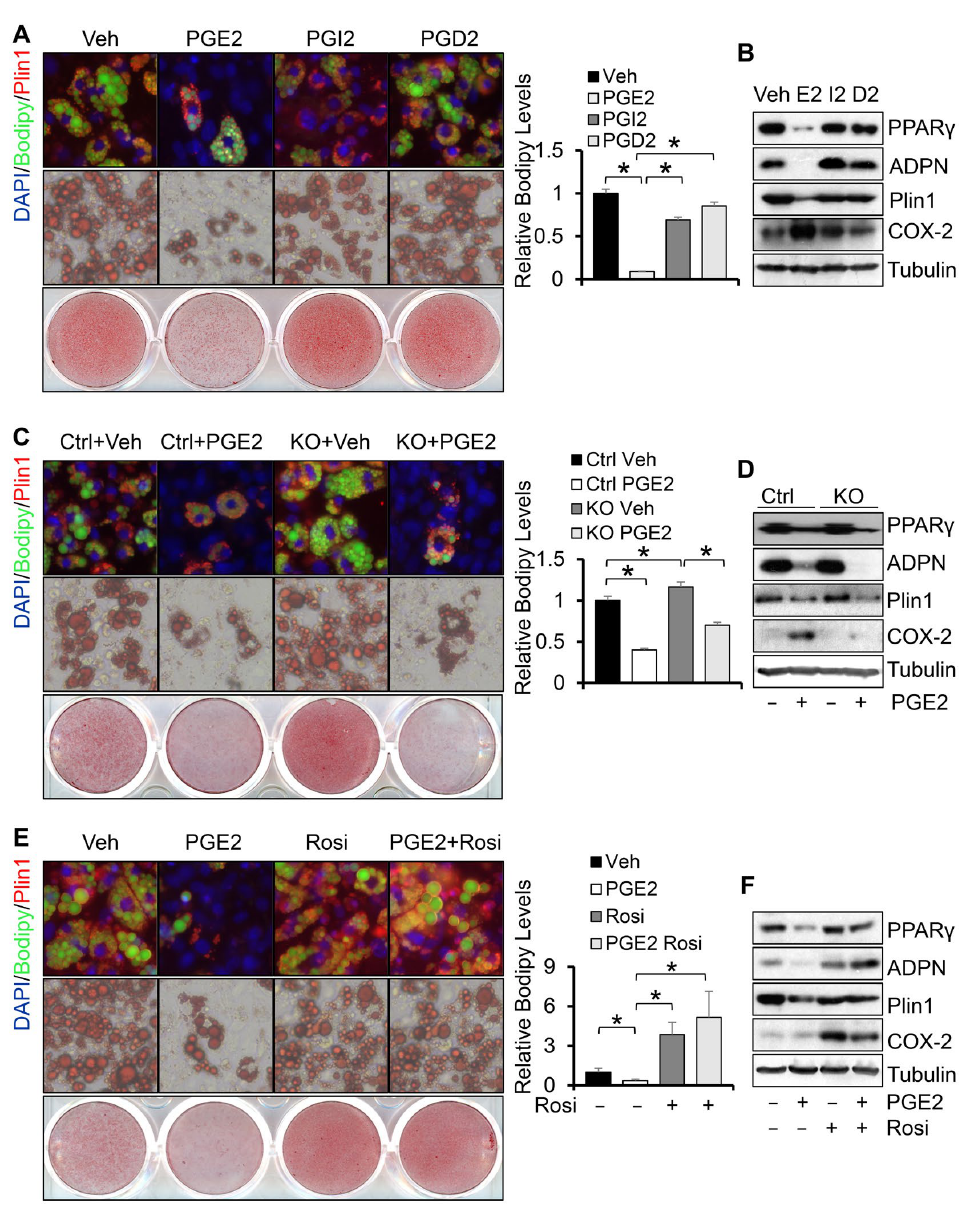
Figure 3. Depletion of COX-2 promotes adipocyte maturation via the PGE2-mediated paracrine mechanism. Treatment of 1 µM PGE2 but not PGD2 and PGI2 suppressed white adipogenesis presented by Oil red O staining and fluorescence staining of Bodipy and Plin1 ( A ) as well as the ex- pression levels of adipogenic markers PPARγ, adiponectin , and Plin1 ( B ). Starting from differenti- ation, primary preadipocytes were treated with 1 µM PGE2, PGI2, and PGD2 for 6 days. Treatment of 1 µM PGE2 reversed COX-2 deficiency-induced white adipogenesis presented by Oil red O stain- ing and fluorescence staining of Bodipy and Plin1 ( C ) as well as the expression levels of adipogenic markers PPARγ, adiponectin , and Plin1 ( D ) in primary adipocytes. Treatment of 10 µM PPARγ agonist Rosiglitazone restored PGE2 treatment-suppressed white adipogenesis presented by Oil red O staining and fluorescence staining of Bodipy and Plin1 ( E ) as well as the expression levels of adi- pogenic markers PPARγ, adiponectin , and Plin1 ( F ) in primary adipocytes. Data in Figure 3A,C,E are presented with means ± S.E.M. * p < 0.05.